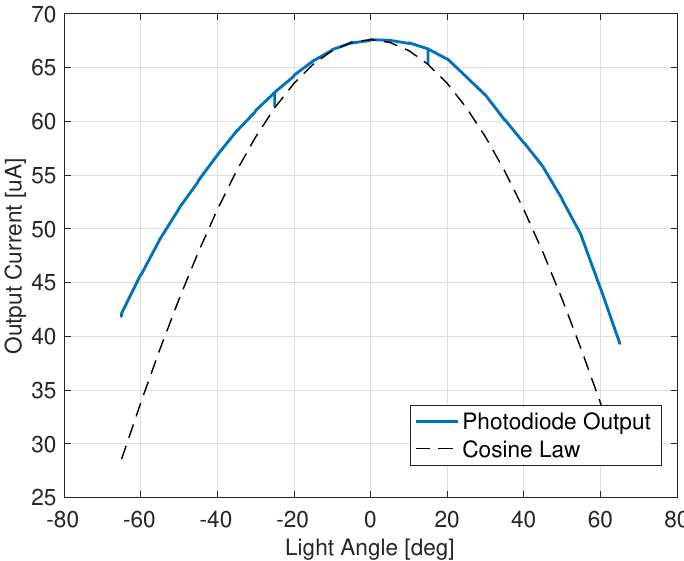
Figure 9. Light measurements with CSS